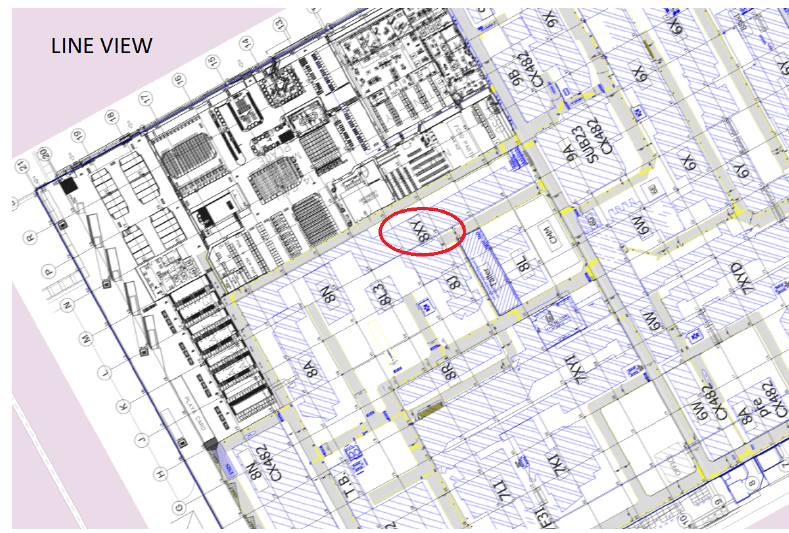
Figure 6. Red circle indicates the 8XY welding line location in the line